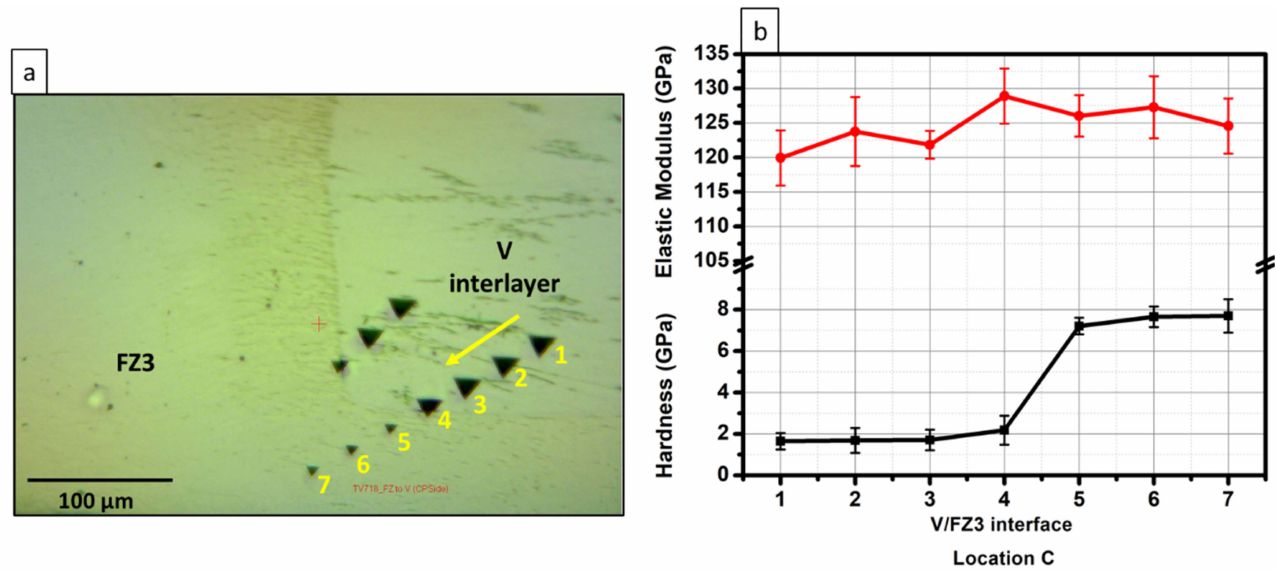
Figure 11. ( a ) Nanohardness line scan at V/FZ3 Interface (location (C) in Figure 8). ( b ) Corresponding hardness and elastic modulus profiles along the line